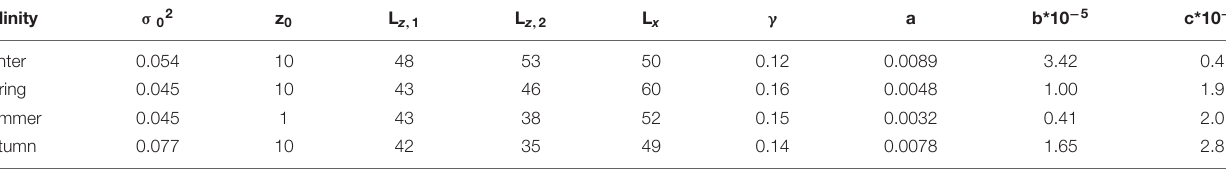
TABLE 2 | Parameters for the analytical expressions for the covariance function for salinity and potential temperature in the Balearic Channels (see Eq. 11). Salinity